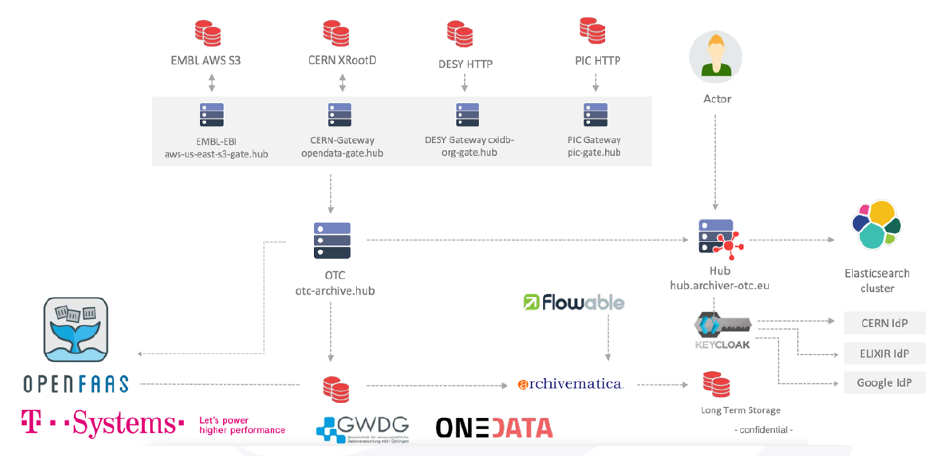
Fig. 6. Prototype architecture of the T-Systems consortium.